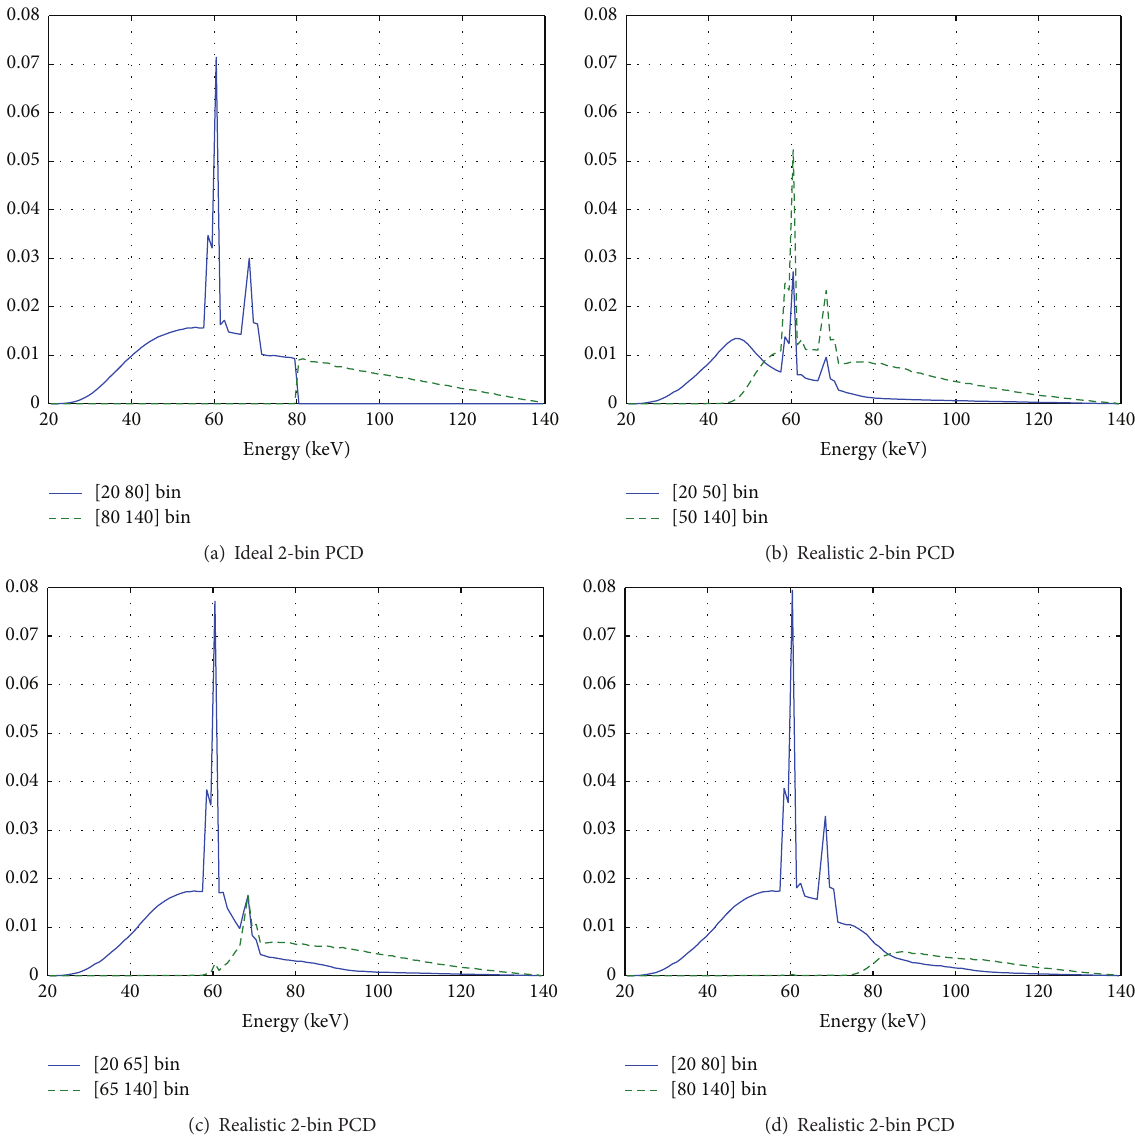
Figure 3: Normalized tube spectrum, prefiltered with 0.9 mm Ti and 3.5 mm Al. Shown are the sensitive ranges of the low bin (blue, solid line) and the high energy bin (green, dashed line) for the ideal (a) and the realistic ((b)–(d)) two-bin PCD, respectively. The energy resolution in the plots is